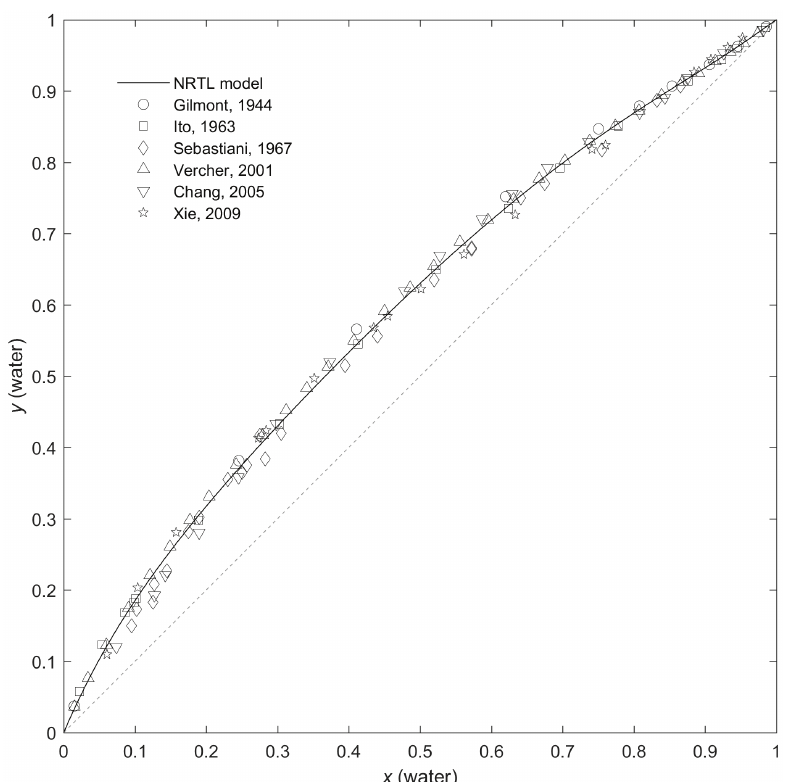
Fig. 4 – VLE data and NRTL model for the acetic acid–water system 26–31